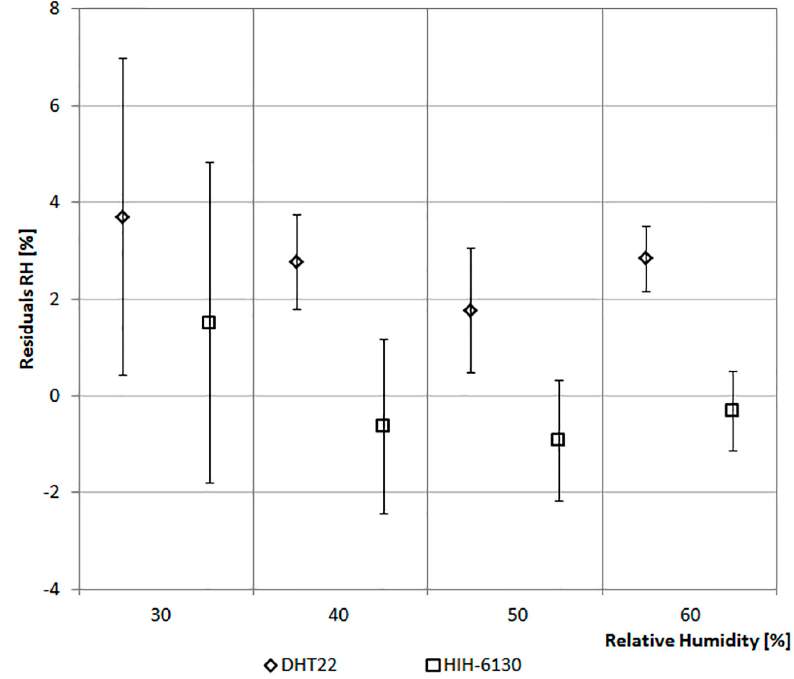
Figure 7. Relative humidity data comparison.